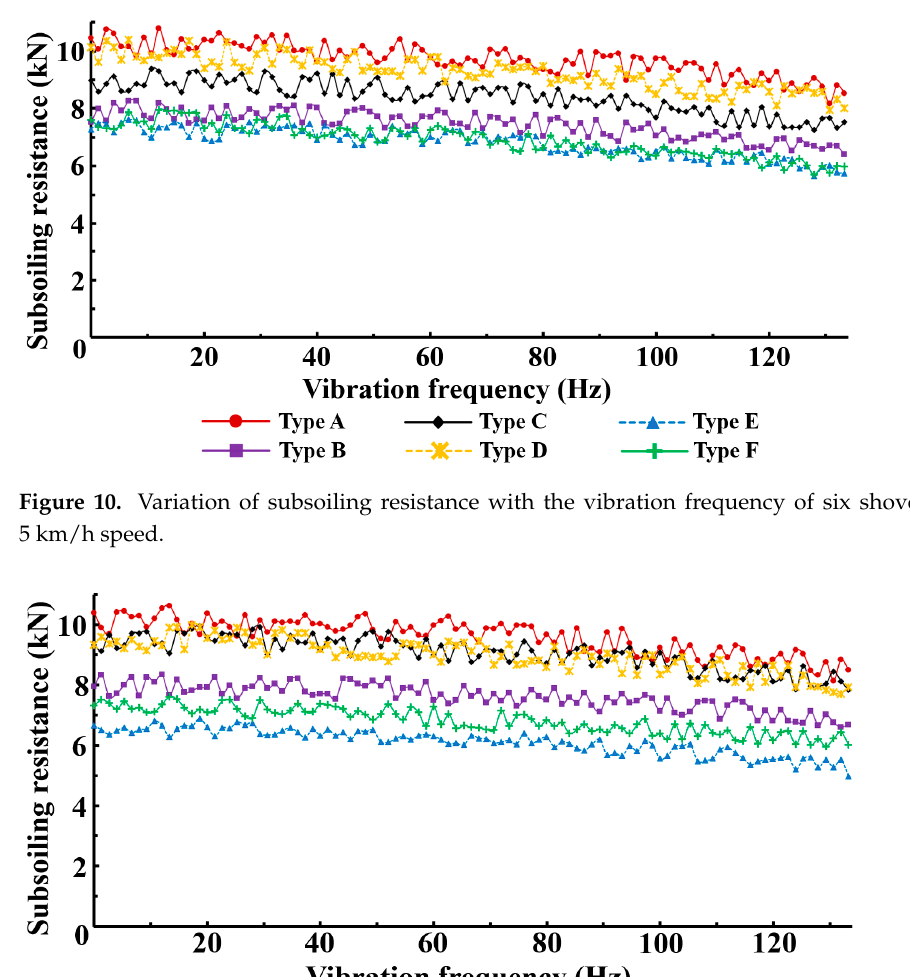
Figure 9. Variation of subsoiling resistance with the vibration frequency of six shovel tips at 3 km/h speed.